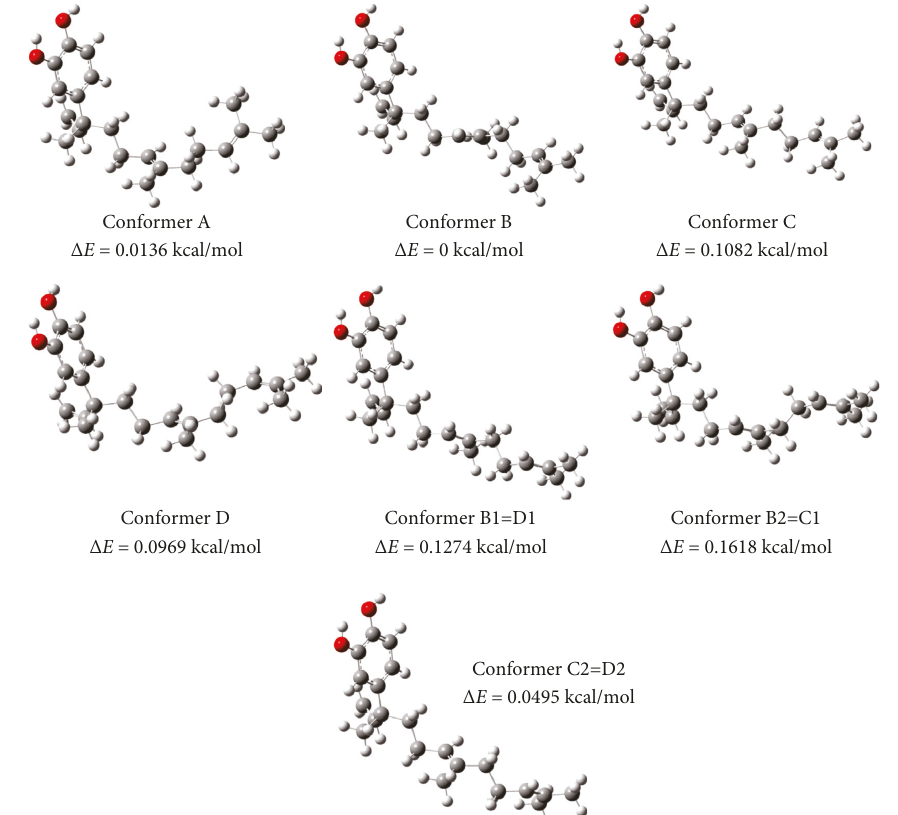
Figure 3: Stable conformational isomers of 4NRC. Table 1: Calculated energy parameters for 4NRC using B3LYP/ 6-311G (2d,p) basis set.